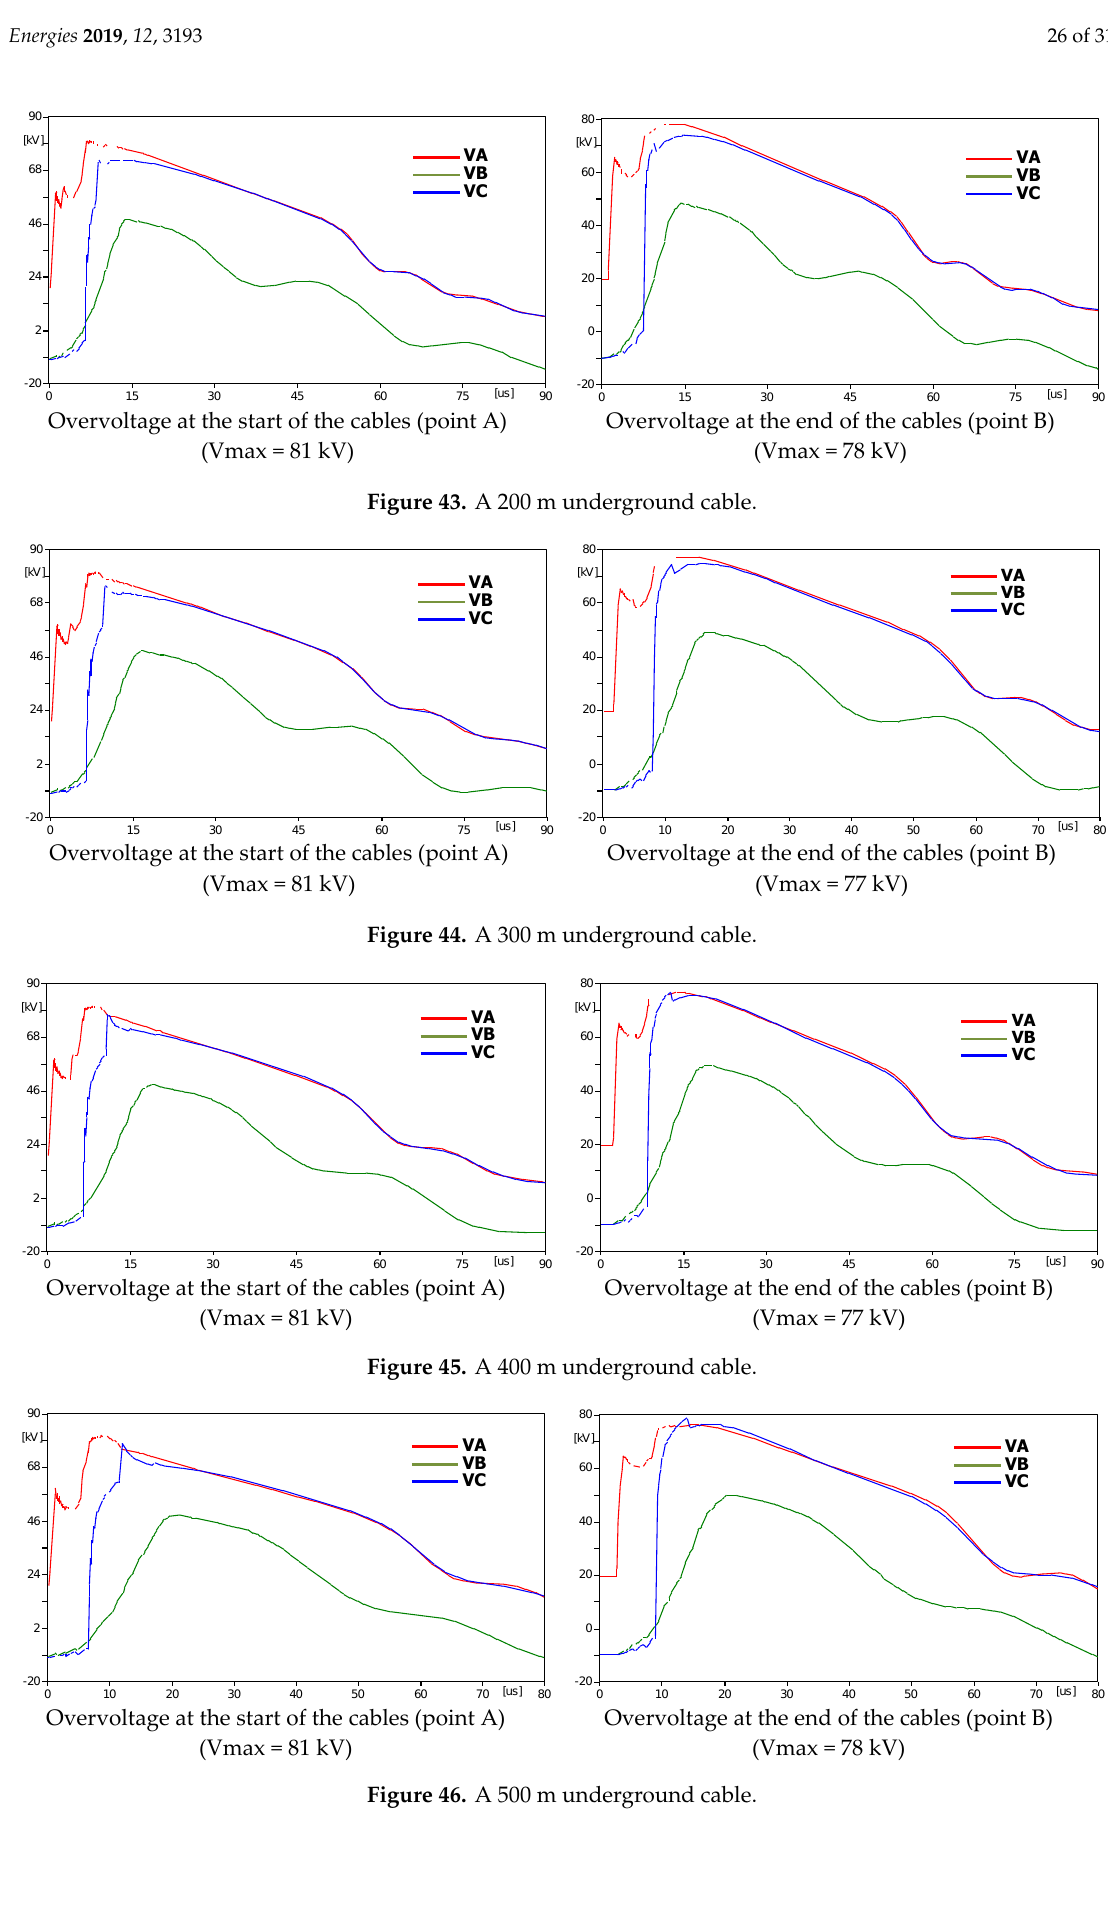
Figure 42. A 100 m underground cable.